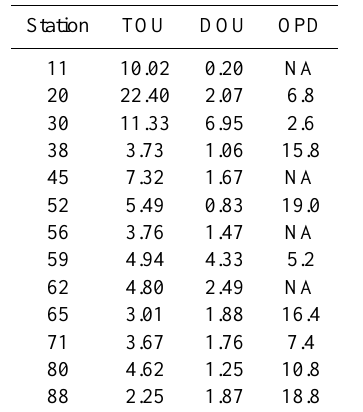
Table 3. Comparison between TOU rates as measured by FireSting optodes and diffusive oxygen uptake rates (DOU) obtained from O 2 microprofiles. Unit: mmolO 2 m − 2 d − 1 ; oxygen penetration depth (OPD) for cores used for microprofiling in mm. NA indicates that oxygen does not deplete over the measured